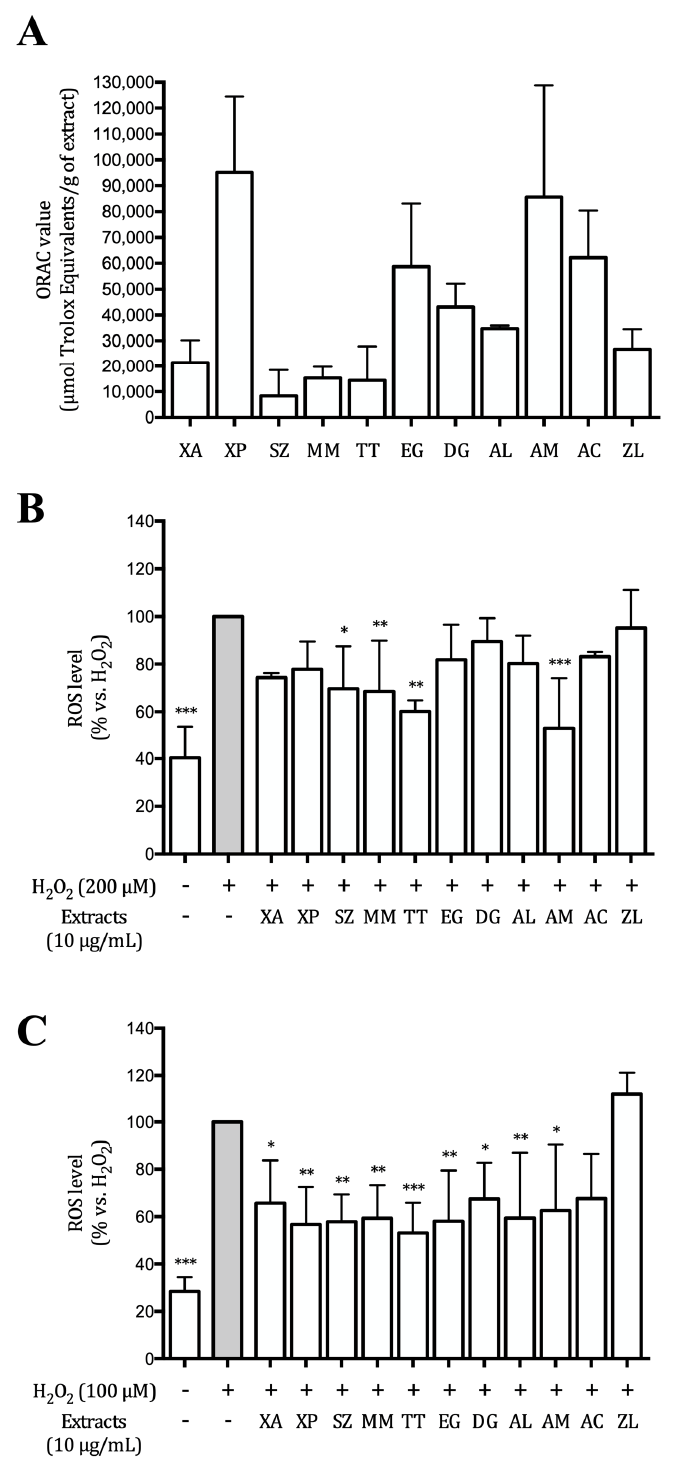
Figure 1. Antioxidant activity of the extracts. Oxygen radical absorbance capacity (ORAC) assay ( A ). Data are expressed as ORAC value ( μ mol Trolox Equivalent/g of sample). Effect of the extracts on intracellular ROS production induced by hydrogen peroxide in human gastric adenocarcinoma (AGS) ( B ) and gastric epithelial (GES-1) ( C ) cells. Antioxidant activity is expressed as μ mol Trolox equivalent. Data reported in panels B and C are expressed as percentage versus the stimulated control (grey bar), to which is arbitrarily assigned the value 100%. * p < 0.05; ** p < 0.01; *** p < 0.001.